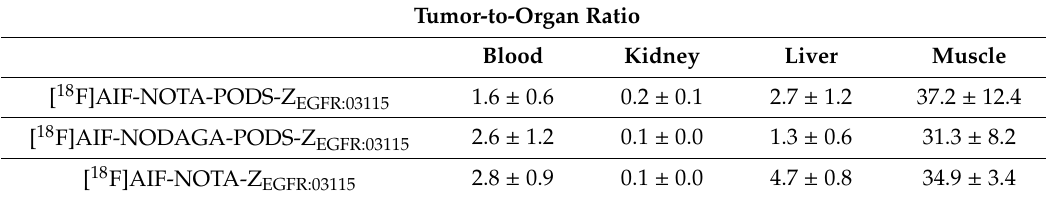
Figure 4. PET / CT images of U87MGvIII tumor-bearing mice using [ 18 F]AlF-NOTA-PODS-Z EGFR:03115 and [ 18 F]AlF-NODAGA-PODS-Z EGFR:03115 . [ 18 F]AlF-NOTA-Z EGFR:03115 was used as control. High-contrast images were acquired as early as 1 h p.i. The tumors are indicated by a white circle. Table 2. Tumor-to-organ ratios at 1 h p.i. of the three examined [ 18 F]AlF conjugates. No differences were identified.